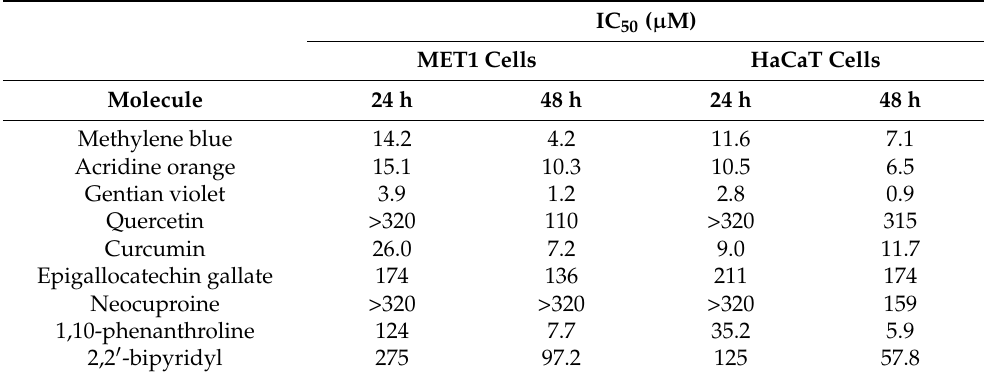
Table 1. Calculated IC 50 values in 24 and 48 h cytotoxicity tests using MET1 and HaCaT cells treated with the dyes (methylene blue, acridine orange and gentian violet), natural compounds (quercetin, curcumin and epigallocatechin gallate) and chelating molecules (neocuproine, phenanthroline and 2,2 (cid:48) -bipyridyl) using concentrations from 1.25 µ M to 320 µ